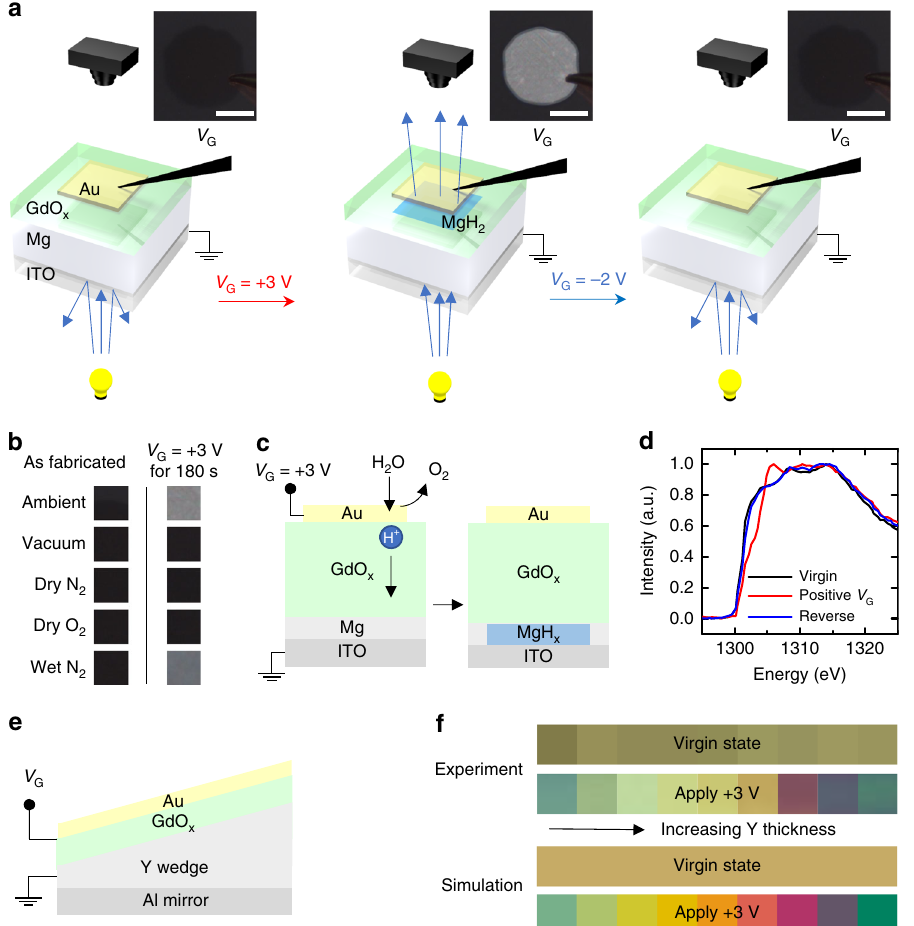
Fig. 1 Hydrogen absorption by bottom electrode. a Device schematic and measurement scheme for switchable transmittance devices. The Ti and Pd layers are omitted. Transmission images are shown to the right of the camera icons. The transmission image became brighter after applying V G = + 3 V and then became darker after applying − 2 V. The scale bar is 400 μ m. b Optical images of the device as fabricated and after applying V G = + 3 V for 180 s in different gas environments (cropped to a square located at the center of the gated region). Transmission change was only observed in ambient and wet N 2 . c Schematic illustration of the electrochemical water splitting and Mg hydrogenation. d X-ray absorption spectra of Ti/Mg/Pd/GdO x /Au devices, in virgin state, after positive V G application, and subsequent negative V G application. e Schematic illustration of re fl ection device with yttrium as bottom electrode. The Ta and Pt layers are omitted. f Optical images and simulated colors of the devices with increasing yttrium thickness as fabricated and after applying V = + 3 V for 180 G Al nanodisk arrays (Fig. 2b) was fabricated on the top (see experimental results. With a later negative V G application, the “ Methods ” section). The entire set of pixels was covered by a 35 colors recovered closely to the virgin state as shown in Fig. 2c nm GdO x layer and a single 3 nm Au top electrode. As shown in (bottom), demonstrating the reversibility of the plasmonic response control. Fig. 2c (top), the disk diameter d and nearest-neighbor separation g were varied from array to array to yield a range of re fl ected colors due to the geometry-dependent plasmonic resonances. The plasmonic resonance depends on the optical properties of the surrounding layers and, therefore, can be controlled by hydrogen loading/unloading. As fabricated, Mg functions as a mirror layer below the Al disks. When a positive V G is applied, hydrogen loading transforms the Mg into transparent MgH x , so that it is no longer a mirror layer. Instead, the bottom Al layer functions as the new mirror layer. Hence, the distance between the Al disks and the mirror layer increases compared to the virgin state due to the inclusion of the MgH x layer. The distance increase causes a blueshift of the resonances. Optical images after applying V G = + 5 V for 120 s are shown in Fig. 2c (middle). Finite-difference time-domain (FDTD) simulations were used to model the re fl ected colors (see “ Methods ” section and Supplementary ure 3c shows a plan-view optical micrograph of a device with = 270 nm in the virgin state. Figure 3d shows that the device Note 1) as shown in Fig. 2c (right) which match well with the t SiO 2